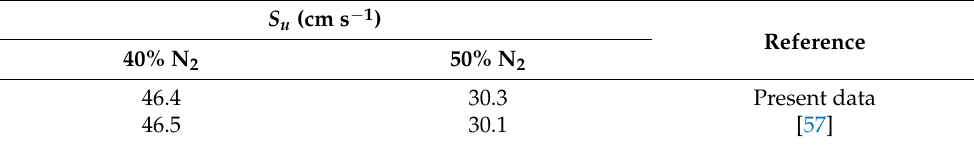
Table 5. Laminar combustion velocities of stoichiometric N 2 -diluted CH 4 -N 2 O mixtures.